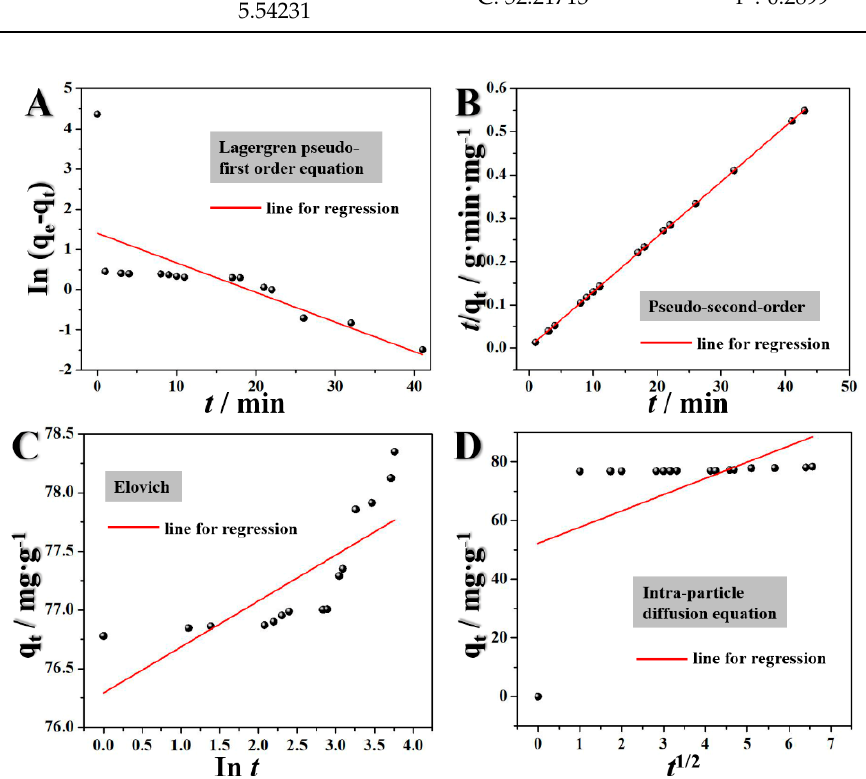
Figure 5. Fitting of Lagergren pseudo ‐ first order ‐ equation ( A ), Pseudo ‐ second ‐ order ( B ), Elovich ( C ) and intra ‐ particle diffusion equation ( D ), respectively. Table 1. Mathematical equations in Rhodamine B adsorption kinetics and kinetic parameters of various models fitted to experimental data.